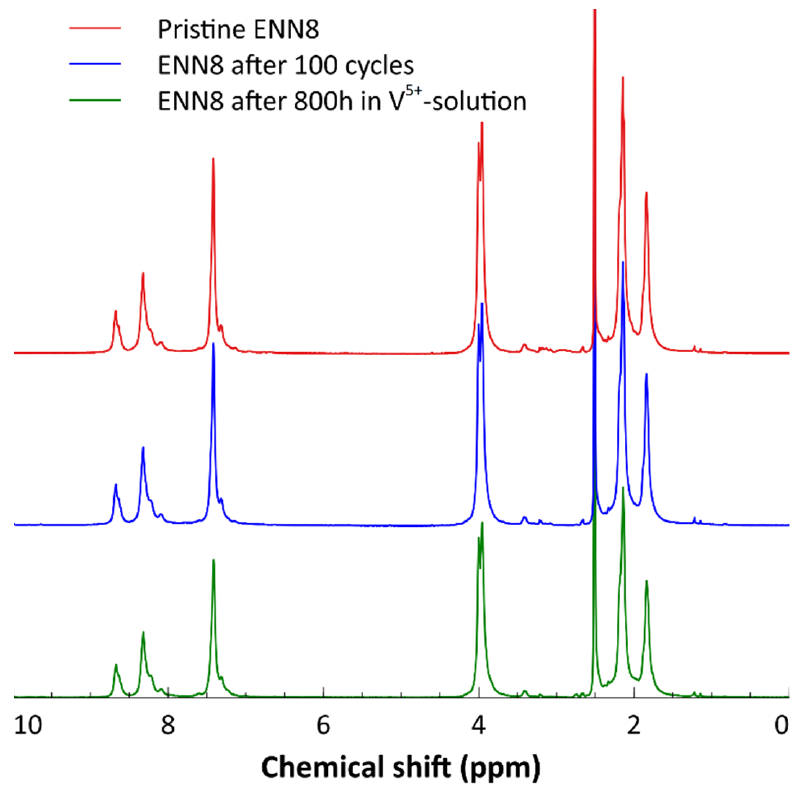
Figure 6. NMR spectra of pristine, cycled and V(V)-exposed ENN8 membrane.